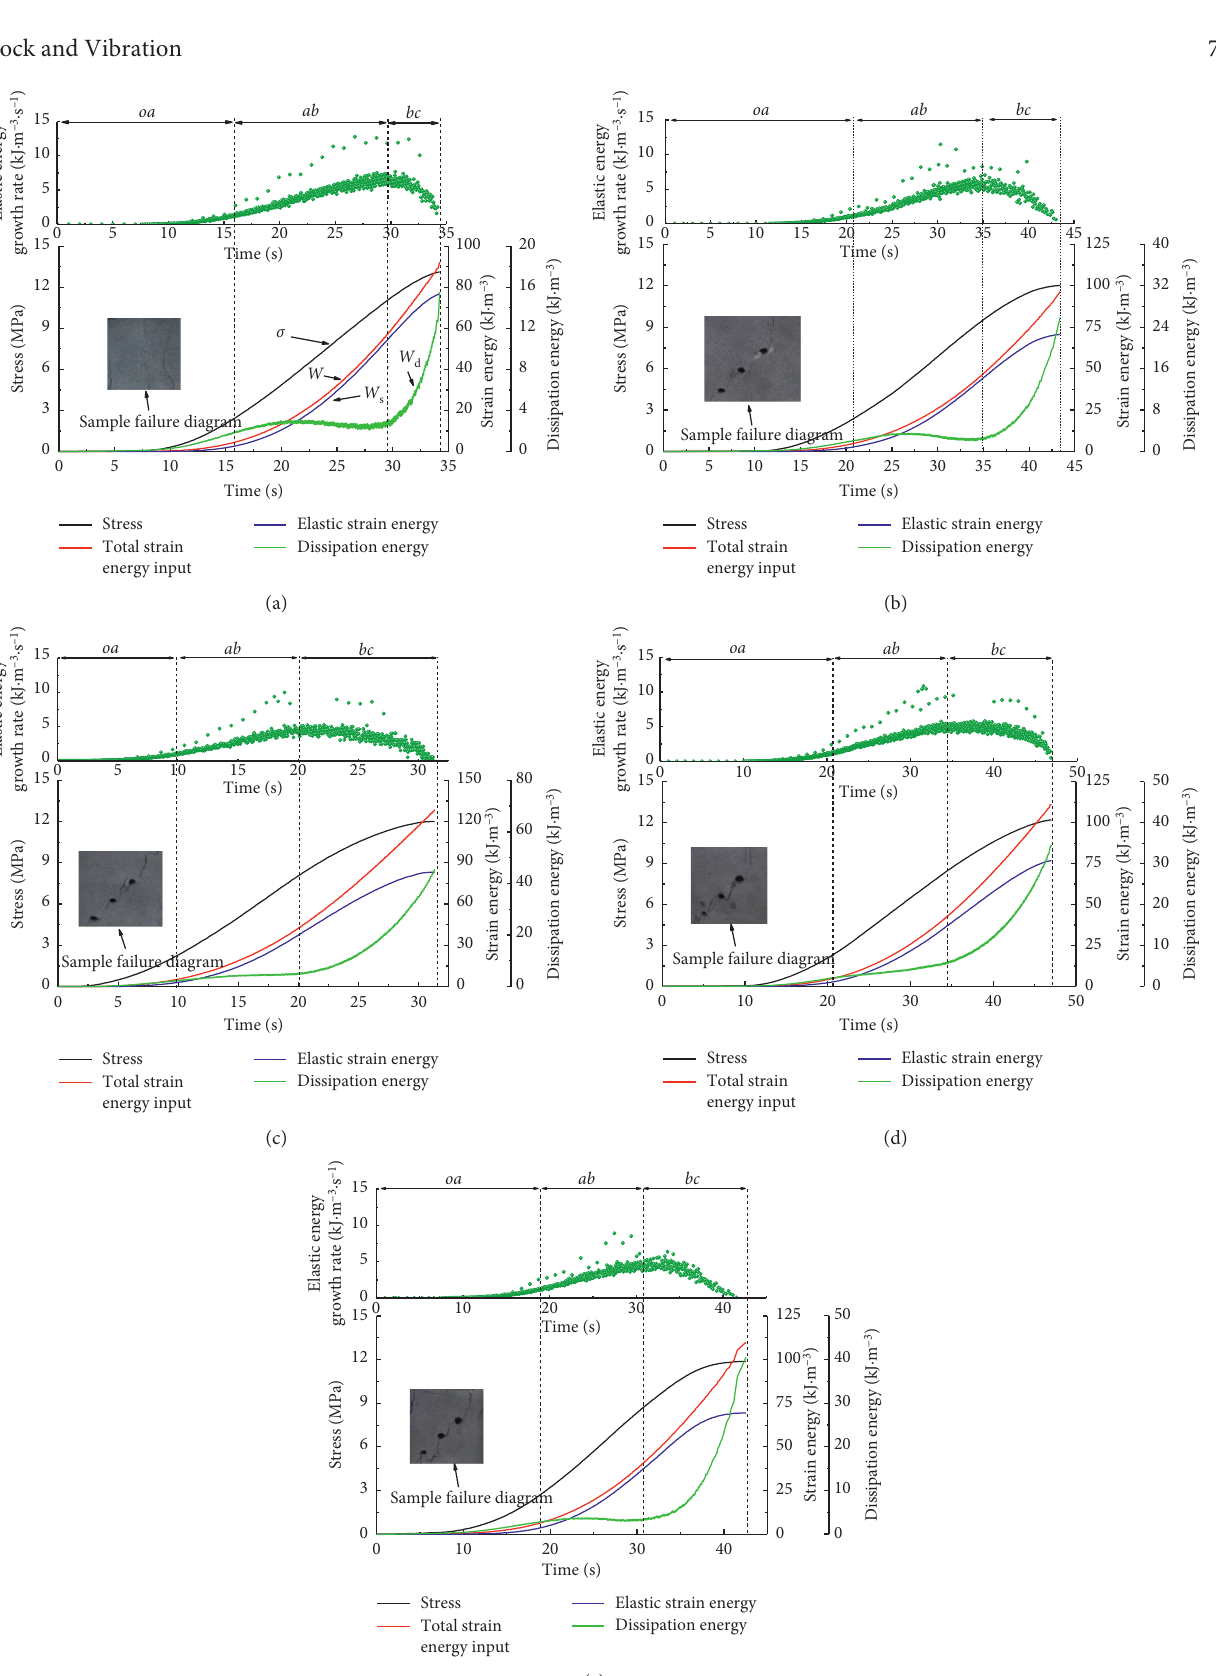
Figure 5: Typical curve of internal energy conversion and elastic energy growth rate of coal-like material sample under different borehole arrangements. (a) Scheme I 01: complete samples. (b) Scheme II 03: samples with boreholes. (c) Scheme III 02: samples with borehole with stepwise increased borehole depth. (d) Scheme IV 03: samples with borehole with stepwise increased borehole diameter. (e) Scheme V 01: samples with borehole with stepwise increased borehole depth and borehole